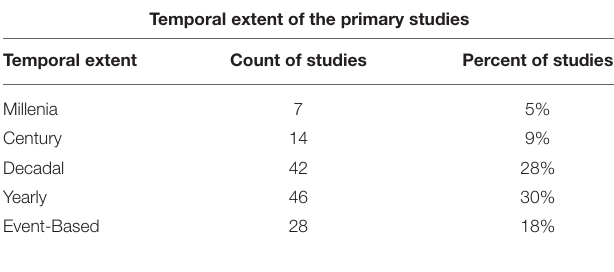
TABLE 7 | Temporal extent identified for the primary studies.